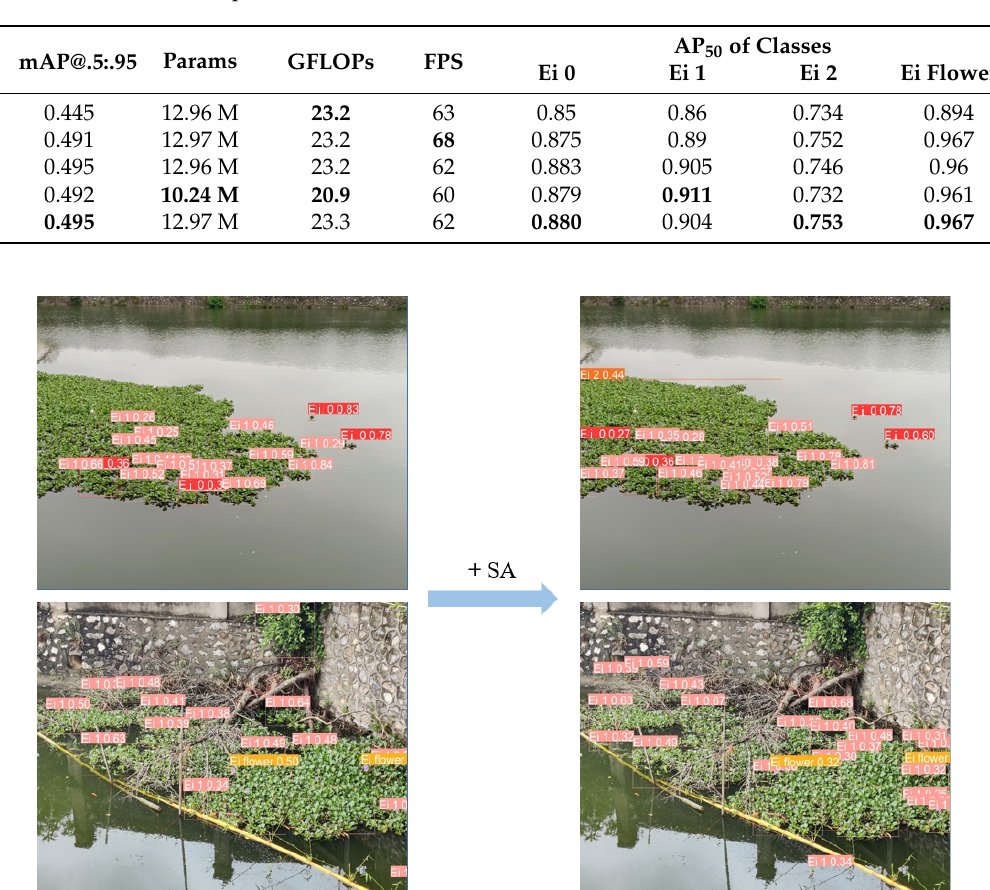
Figure 13. Detection effect of efficient YOLOV5 in different environments. Table 6. Ablation experiment results.